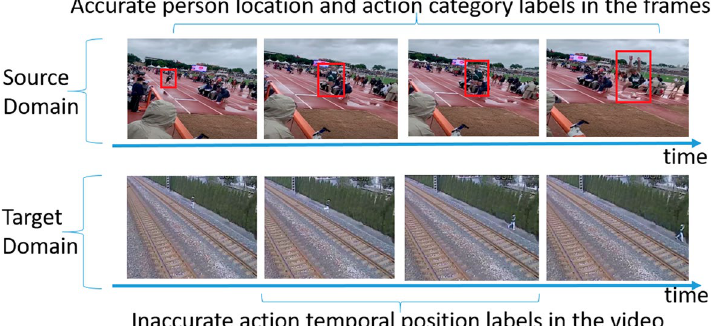
Fig. 1 Source domain has accurate person location and action category labels in the frames, and the target domain only has inaccurate action temporal position labels in the